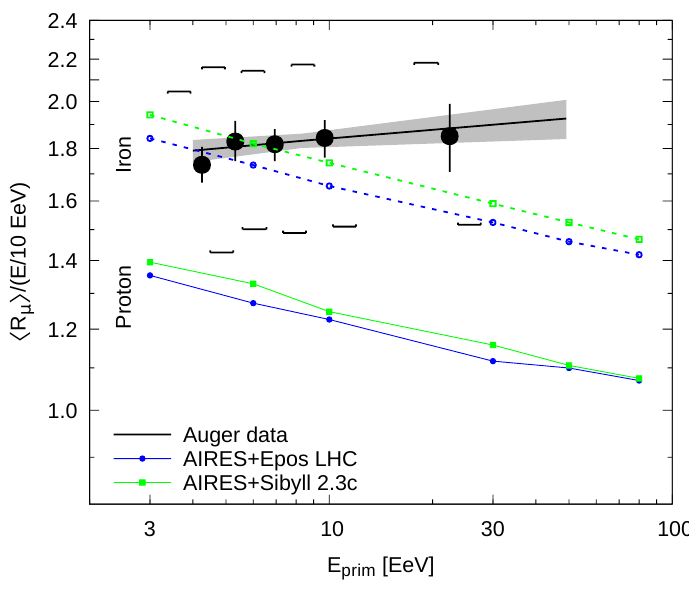
Figure 1. (cid:104) R µ (cid:105) / E prim versus primary energy (I). The black circles, straight line with grey shaded zone, and square horizontal brackets correspond to data published by the Pierre Auger Observatory in reference [5] (figure 4). Circles error bars and grey shaded zone indi- cate statistical uncertainties, while the horizontal brackets stand for systematic ones. The blue and green lines correspond to estimations of R MC obtained from simulations with AIRES, linked to the hadronic models indicated in the graph, following the procedure described µ in section